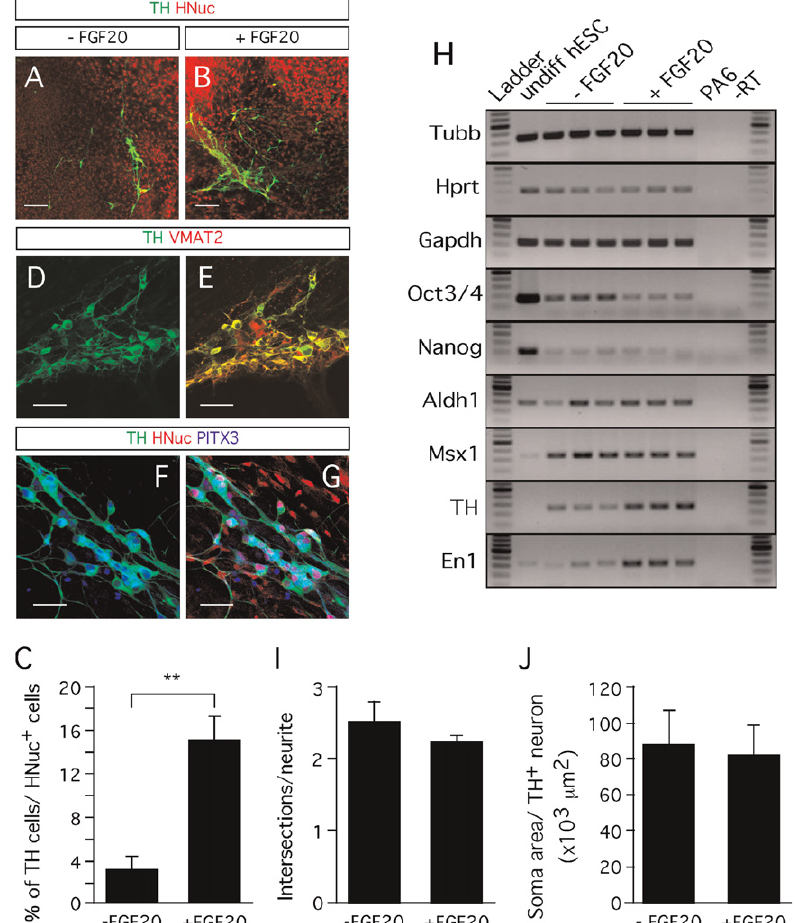
Figure 2. Effect of FGF-20 on dopaminergic differentiation. ( A , B ) Representative images of TH- and HNuc-positive cells in 3 weeks differentiated hESCs/PA6 co-cultures untreated ( A ) and treated ( B ) with FGF-20 ( (cid:2) FGF-20 and þ FGF-20, respectively). ( C ) Graphic representation of the percentages of TH-positive cells among HNuc-positive cells in 3 weeks differentiated hESCs/PA6 co-cultures (cid:2) FGF-20 and þ FGF-20. Average (cid:1) SEM. Student’s t-test, p-value: ** ¼ 0.0012. ( D , E ) Co-expression of TH and the vesicular monoamine transporter (VMAT) 2. ( F , G ) Co-expression of TH and the paired-like homeodomain transcription factor 3 (PITX3). ( H ) RT-PCR analysis of gene expression on undifferentiated hESCs (undiff hESC line); PA6 mouse stromal cells (PA6 line); 3 weeks differentiated hESCs/ PA6 co-cultures without FGF-20 ( (cid:2) FGF-20 lines) and with FGF-20 ( þ FGF-20 lines). Undiff hESCs, undifferentiated human embryonic stem cells; (cid:2) RT, no polymerase negative control. The three lines falling into both (cid:2) FGF-20 and þ FGF-20 conditions represent the RT-PCR analysis of three separate cultures maintained in the condition indicated. ( I ) Estimation of the TH-positive neurites length by the number of intersections of the neurites with probe lines in 3 weeks differentiated hESCs/PA6 co-cultures (cid:2) FGF-20 and þ FGF-20. Average (cid:1) SD. ( J ) Soma area of TH-positive neurons in 3 weeks differentiated hESCs/PA6 co- cultures (cid:2) FGF-20 and þ FGF-20. Average (cid:1) SD. Distance bars: A, B: 200 m m; D–G: 50 m